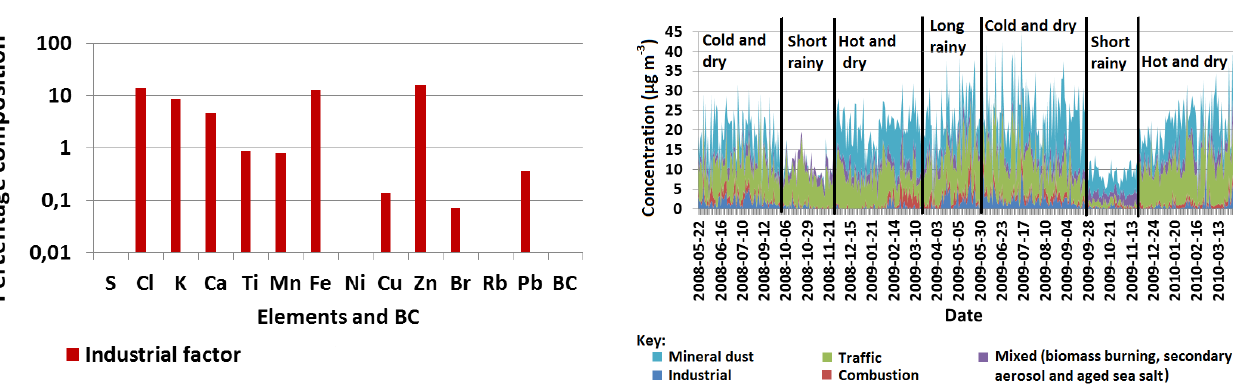
Figure 10. Combustion factor from the PMF analysis of PM 2 . 5 from this study compared with combustion factor from Skopje, Macedonia (Kovacevik et al., 2011).